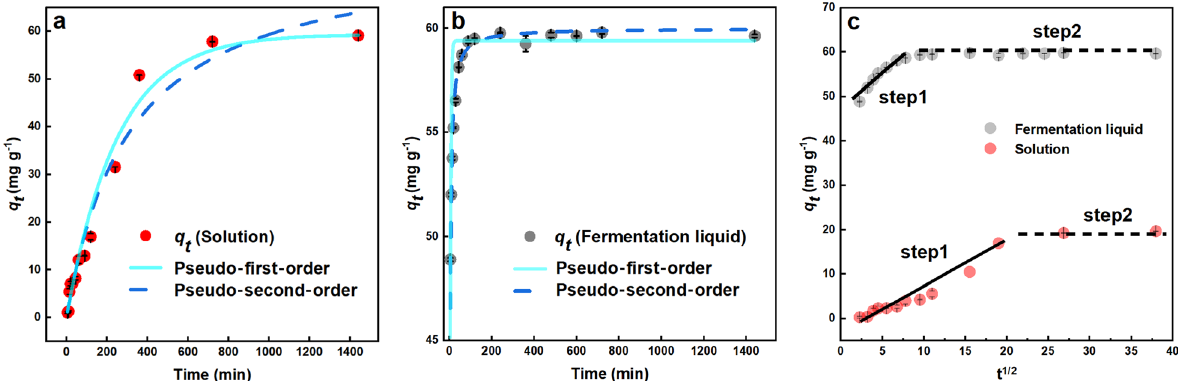
Fig. 4 Adsorption kinetics in the synthetic solution ( a ) and the kitchen waste fermentation liquid ( b ) fitted with the pseudo-first-order and pseudo-second-order models; and fitted with intraparticle diffusion model ( c )